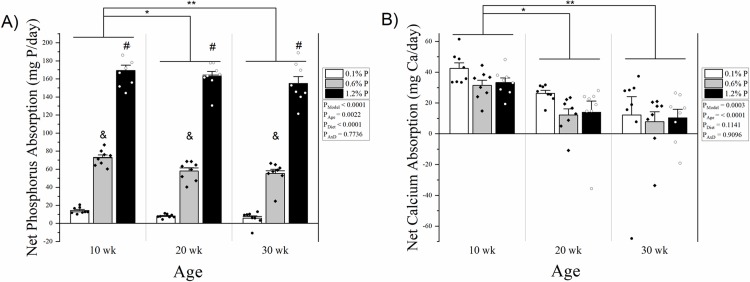
A) Net phosphorus absorption by age and dietary phosphorus intake level. There was a main effect for age where 10 week old rats had higher net phosphorus absorption compared to both 20 and 30 week olds, and net absorption increased with each phosphorus level in the diet, with no significant age x diet interaction. B) Net calcium absorption by age and dietary phosphorus intake level. There was a main effect for age where 10 week old rats had higher calcium balance compared to both 20 and 30 week olds, but there was no significant effect of dietary phosphorus intake level and no significant age x diet interaction. Net absorption for each mineral was calculated as intake–fecal. Means and standard error bars are shown for each group. Low phosphorus diet (0.1%) is shown in white bars and black dots; normal phosphorus diet (0.6%) is shown in grey with black diamonds; and high phosphorus diet (1.2%) is shown in black with white circles. ANOVA p-values for the overall model (PModel), main effect of age (PAge), main effect of diet (PDiet), and interaction of age and diet (PAxD) are shown. * p < 0.05, ** p < 0.01, # p < 0.0001 vs normal and low phosphorus, & p < 0.0001 vs high and low phosphorus.